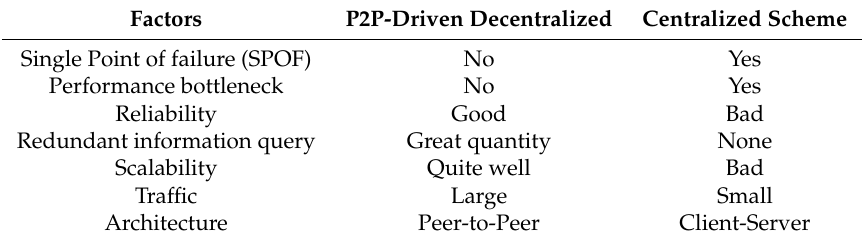
Table 2. Salient features of P2P decentralized